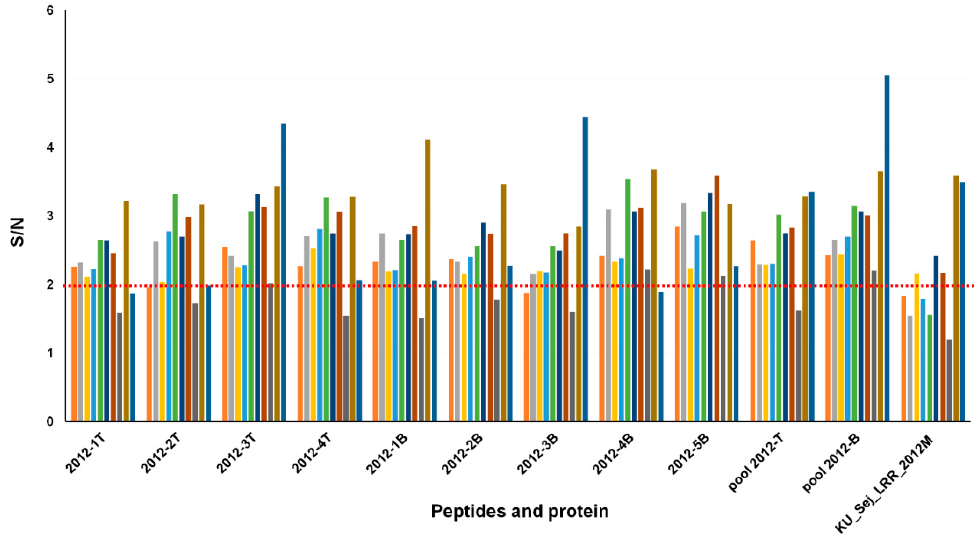
Figure 2. Signal-to-noise (S/N) ratio of the rKU_Sej_LRR_2012M and its derived peptides. The rKU_Sej_LRR_2012M and its peptides were tested with 9 rabbit hyperimmune sera against Leptospira , Anti-2012 and the control rabbit serum. The S/N ratio is the ratio of the absorbance of rabbit hyperimmune serum to rabbit control serum (signal per noise; S/N). The cut-off was set at a 2-fold increase in signal over the control. All samples were tested in triplicate.